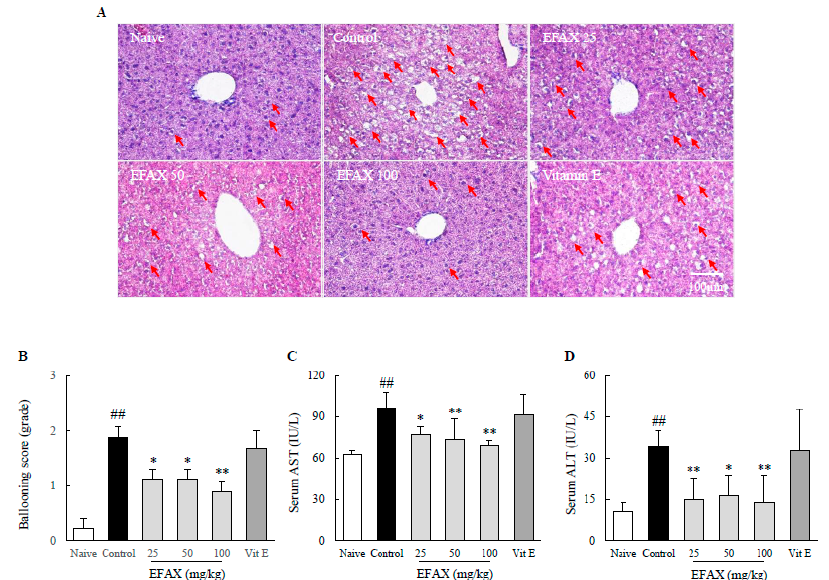
Figure 4. E ff ects on hepatic injuries. Mice ( n = 8 in each group) were fed a 60% high-fat diet for 8 weeks, excluding naive group (normal chow diet). From the 3rd week of high-fat diet feeding, distilled water (control), EF AX (25 mg / kg, 50 mg / kg, 100 mg / kg), and vitamin E (100 mg / kg) were administered by gavage daily for the last 6 weeks. H&E staining ( A ) of liver sections was performed, and representative photographs (200 × magnification) were semi-quantified ( B ). The red arrows indicate ballooned hepatocytes. Serum levels of aspartate aminotransferase (AST) ( C ) and alanine aminotransferase (ALT) ( D ) were evaluated. ## p < 0.01 compared with the naive group; * p < 0.05, ** p < 0.01 compared with the control group. Nutrients 2020 , 07 , x FOR PEER REVIEW